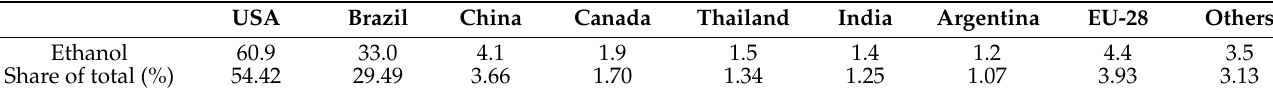
Table 1. Global bioethanol production in 2018 (billion liters)